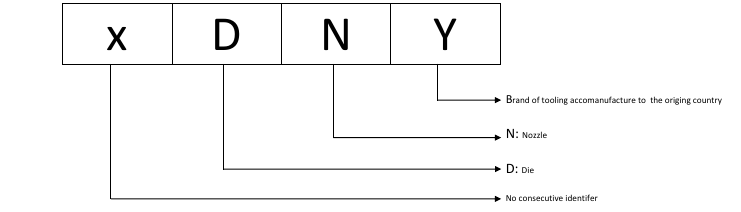
Figure 2. Representation die-nozzle.